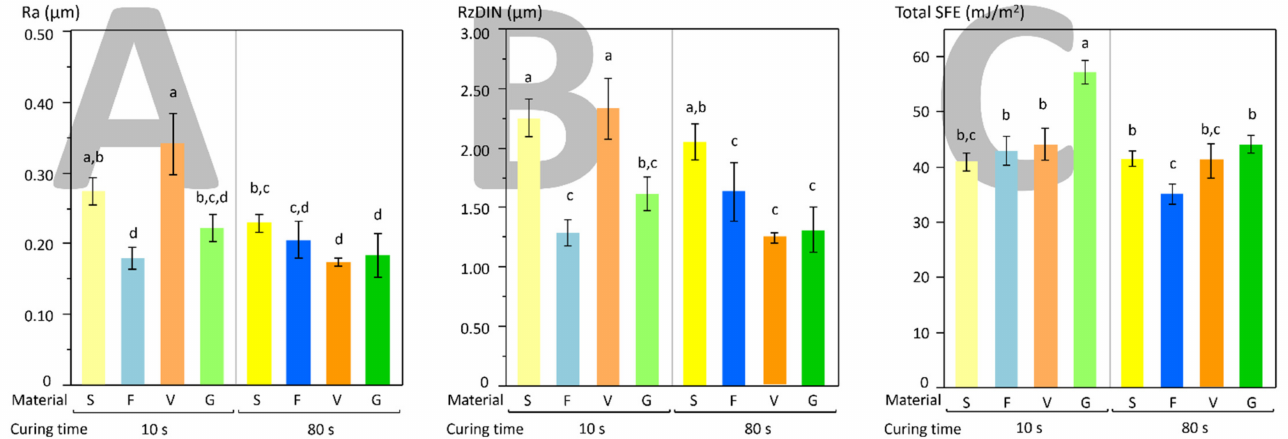
Figure 3. Graphs depicting the results of surface characterization in terms of surface roughness ( A ) Ra parameter and ( B ) RzDIN parameter and surface free energy ( C ). Curing time had a huge impact on both surface roughness and SFE, with differences between tested polymeric materials being significantly reduced after extended curing (80 s). Different superscript letters indicate significant differences between materials (Tukey’s test, p < 0.05) for a given element.